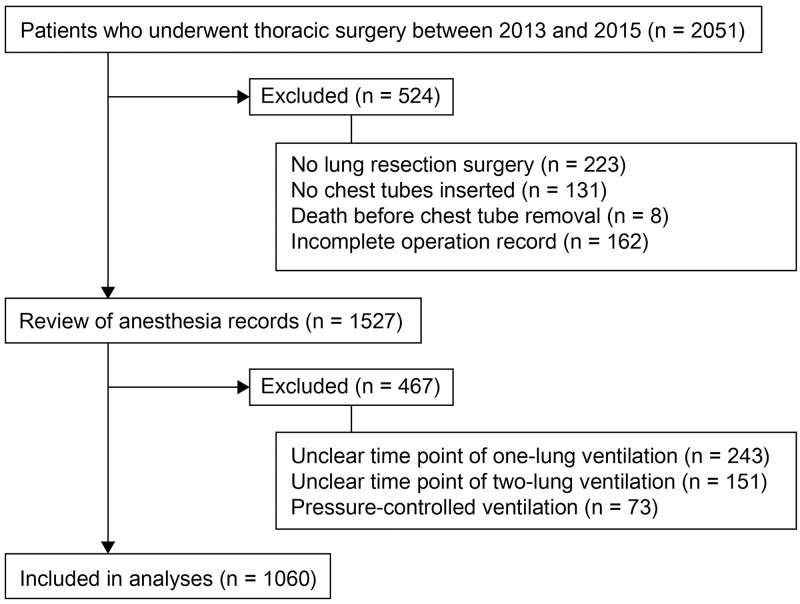
Flow diagram of study.